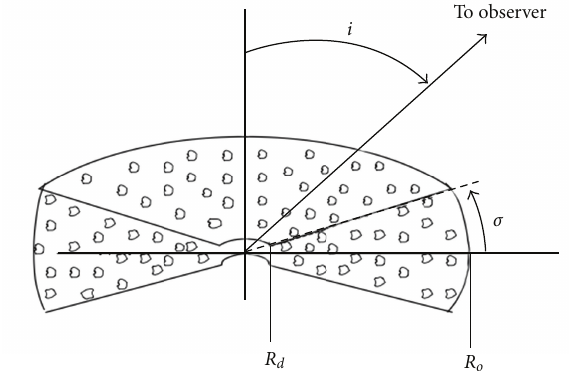
Figure 4: Sketch of the dusty torus as in the model of Nenkova et al. [38], which can reproduce the observed dust temperature distributions derived from infrared